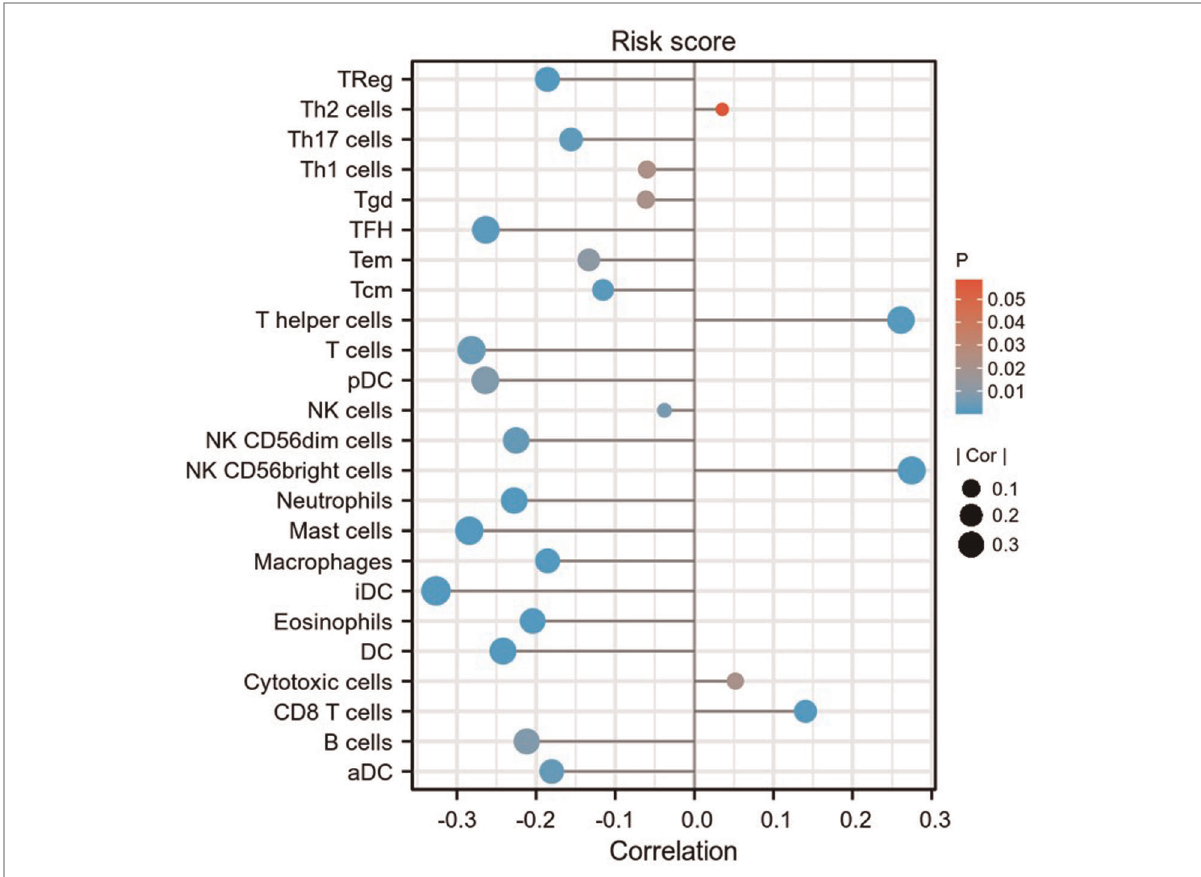
FIGURE 14 Relationship between risk score and immune in fi ltration. Lollipop plot shows the correlation between risk score and 24 immune cell subsets in fi ltration. The size of dots indicates the absolute Spearman r